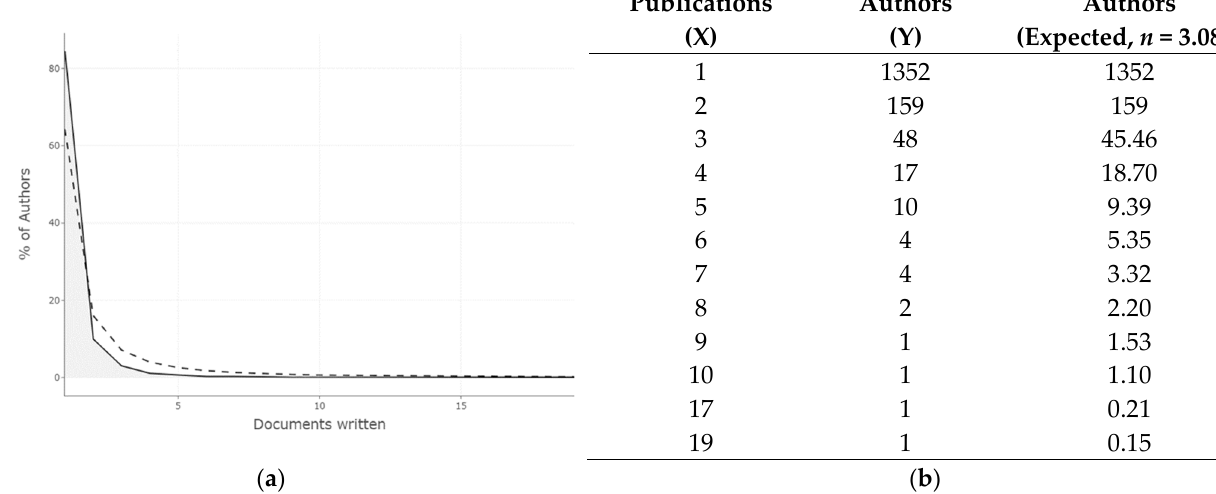
Figure 4. Author Productivity through Lotka’s Law ( a ) The number of publications and the number of authors in the collection are illustrated; ( b ) The number of publications (X), the number of authors (Y), and the expected number of authors calculated through the law are